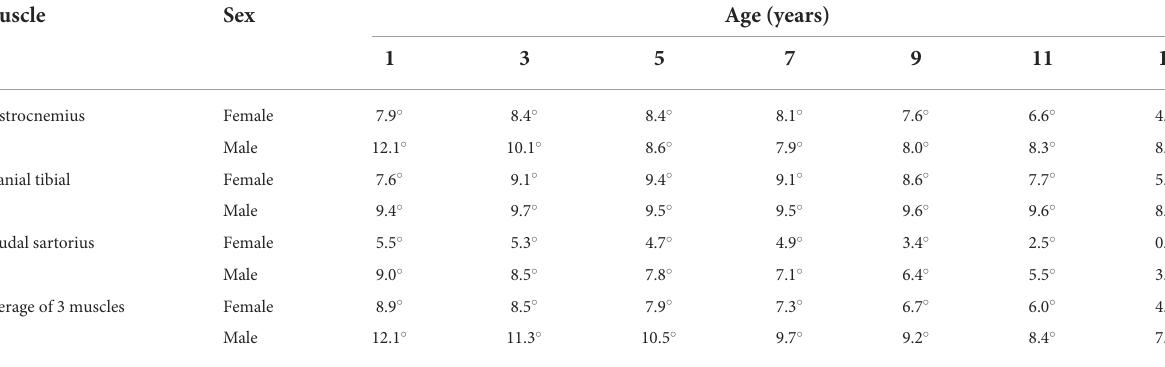
TABLE 2 Lower limit of 95% prediction from the second-degree polynomial regression showing phase reduction with increasing age. Muscle